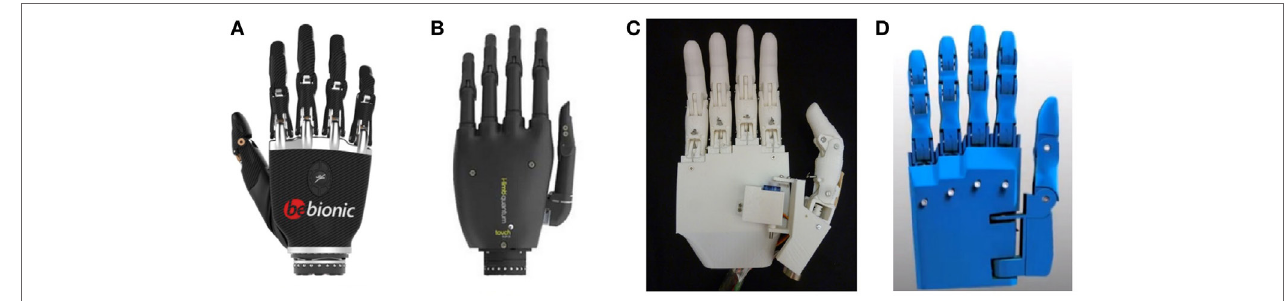
FigUre 1 | (From left to right) (a) Bebionic hand, (B) i-Limb hand, (c) Tact hand (Slade et al., 2015), and (D) Dextrus hand.